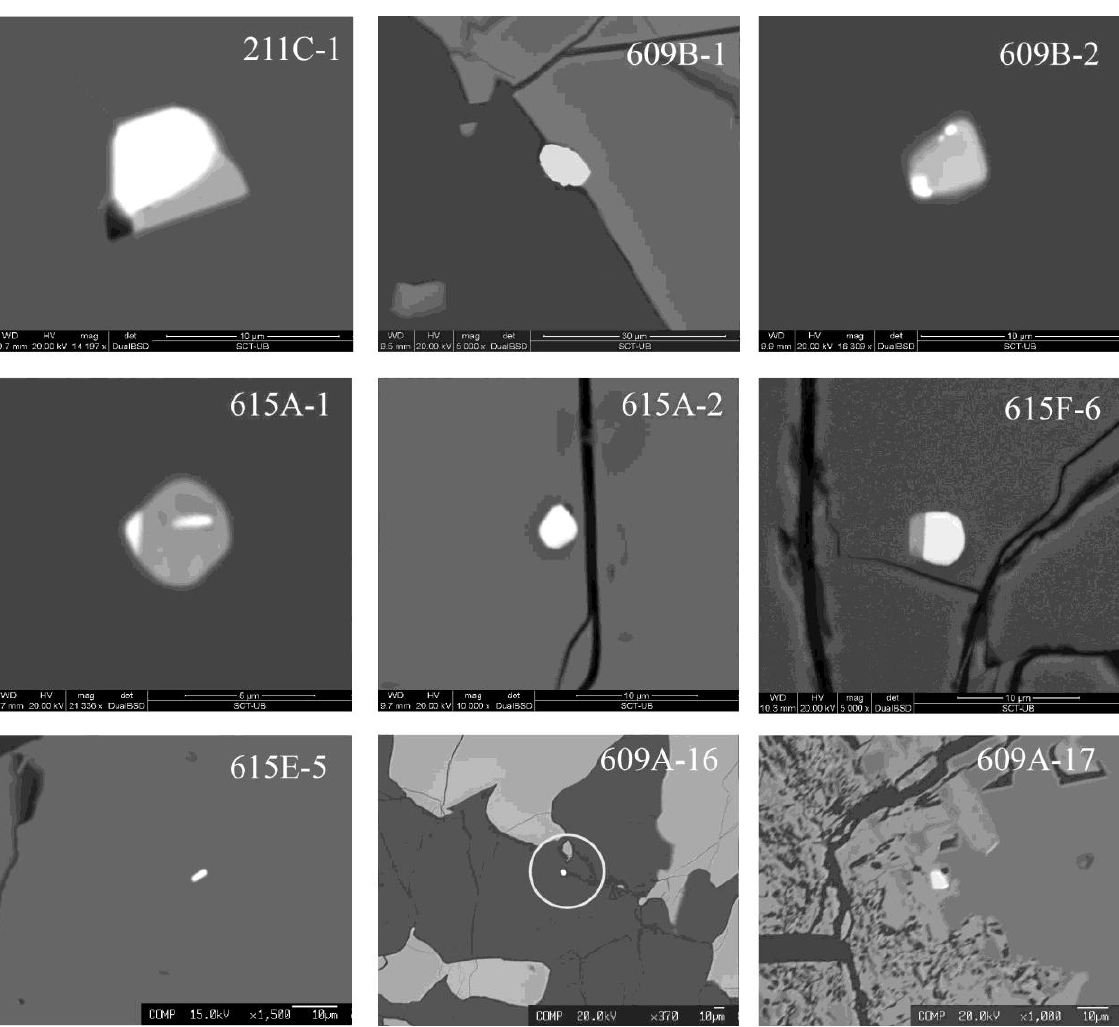
(Figure 13). Electron microprobe composition is consistent with